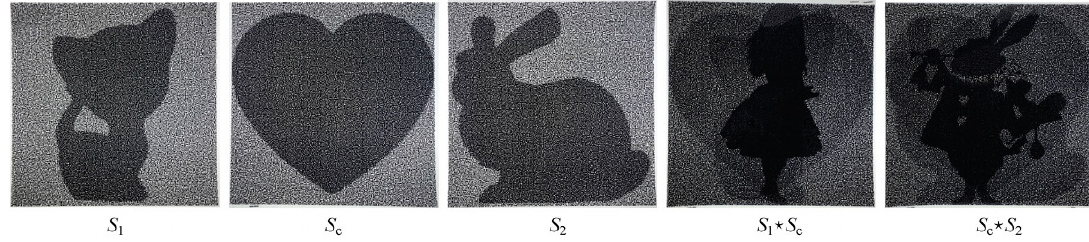
Fig. 8 Output shares printed on transparencies.